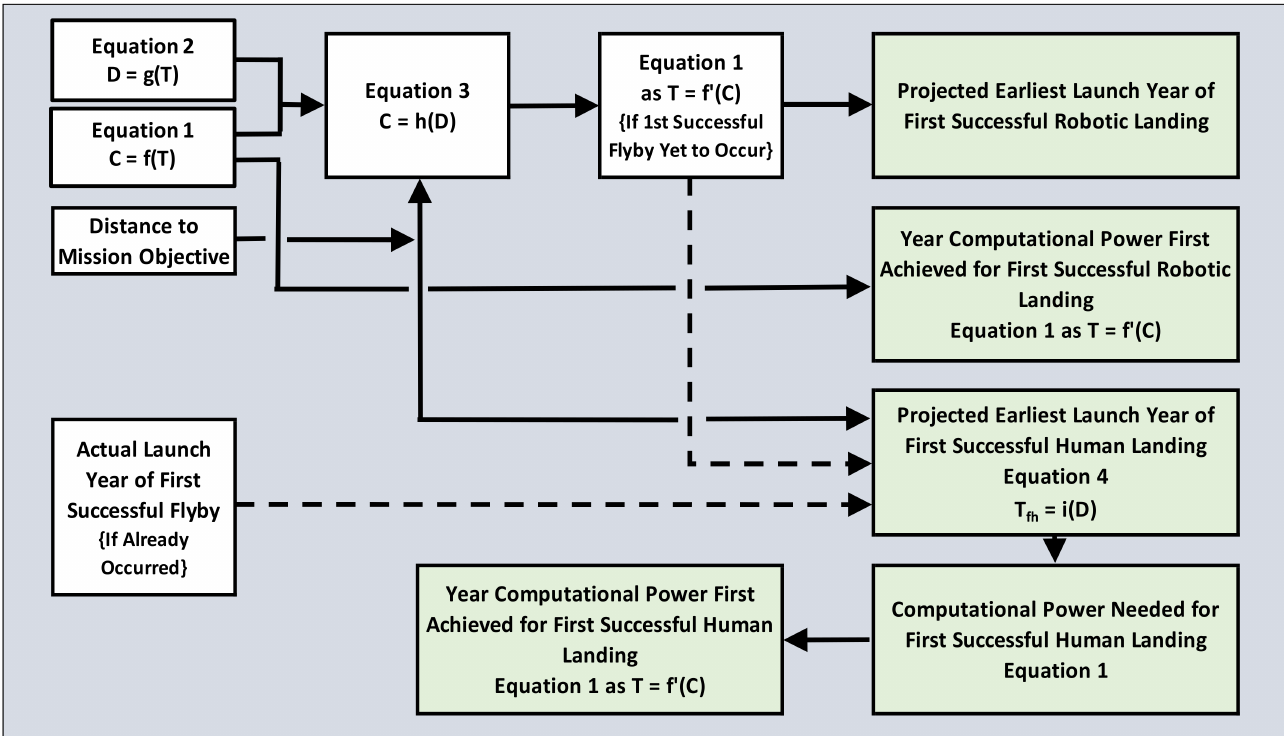
Figure 3. Empirical Equations (1) and (2), in combination with distance to mission objective and flyby mission launch year data, yield projections for extended missions’ launch years and computational power required. Note: “f”, “f’”, “g”, “h” and “i” denote functional